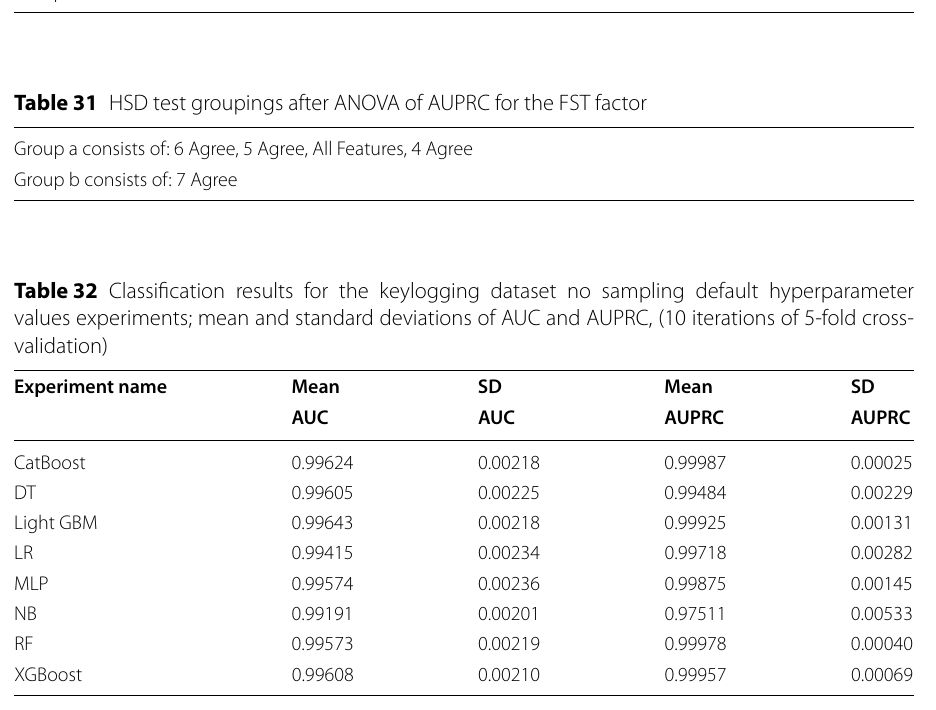
Table 30 HSD test groupings after ANOVA of AUPRC for the hyperparameters factor Group a consists of: Tuned Group b consists of: Default